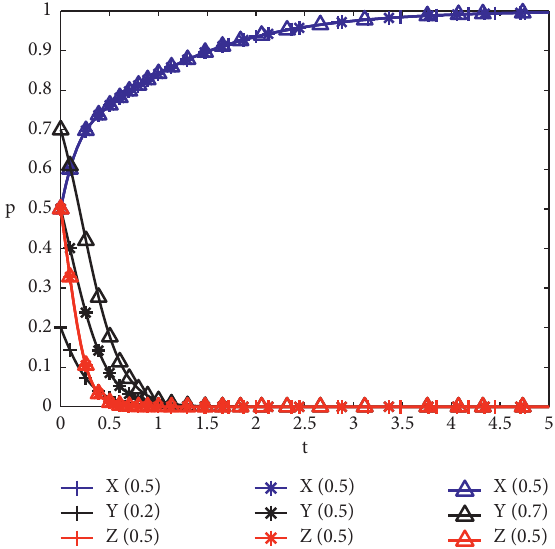
Figure 6: The evolution result of the change of public’s initial